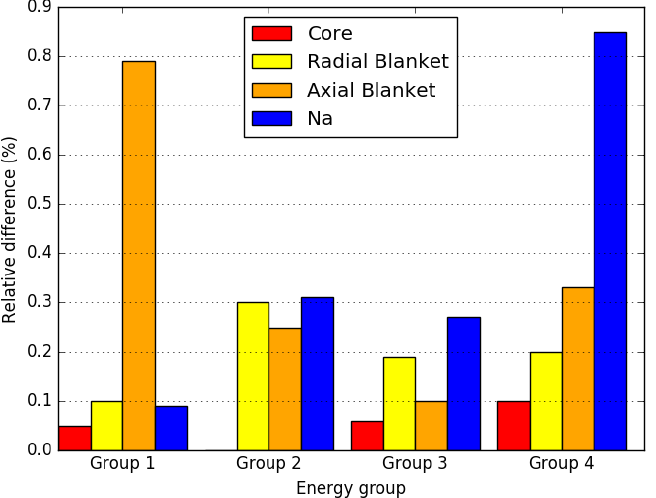
Figure 13. Comparison of region-averaged flux from reference and AZTRAN Model 2 Case